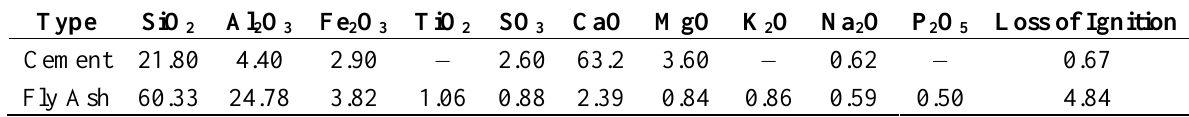
Table 2. Selected chemical properties of cement and fly ash (Unit: